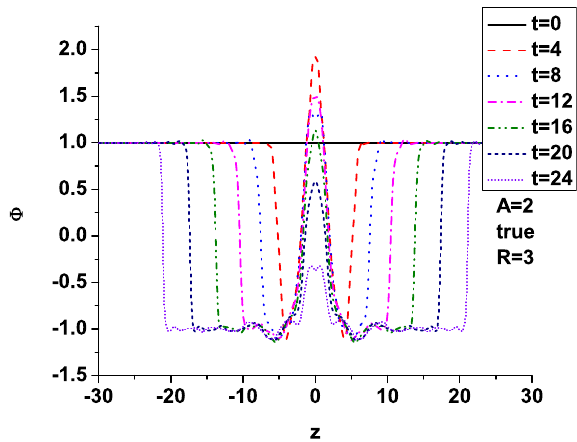
Figure 12 . If the massive object is large enough, the bubble of true vacuum will expand. We set here initial v O = 0 , A = 2 , R = 3 , m = 10 10 , a = − 0 . 2 , r = 0